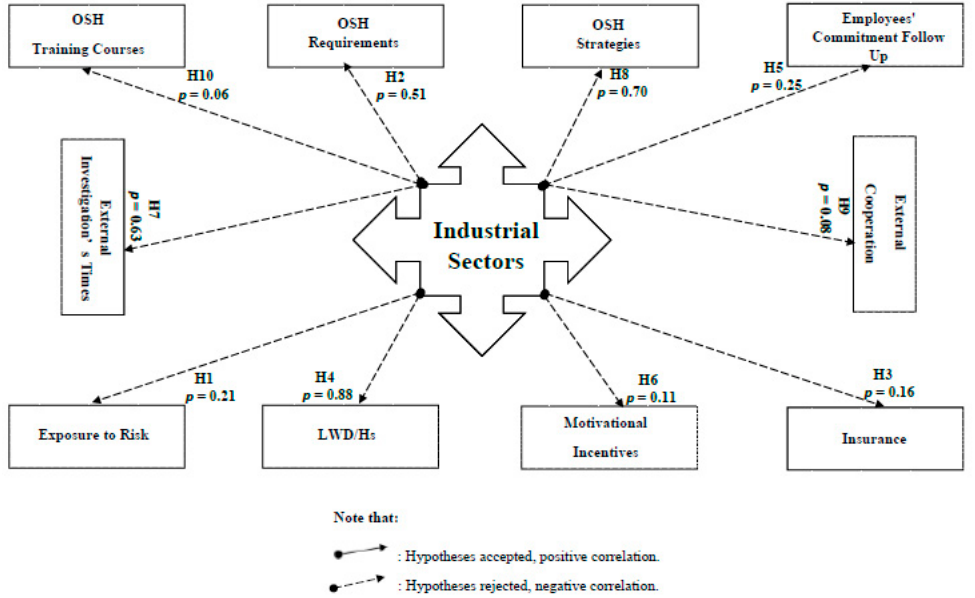
Figure 21. The presentation of case correlation (2) and its hypothesis testing. Case correlation (3) is another illustration of correlations between the OSH variables.